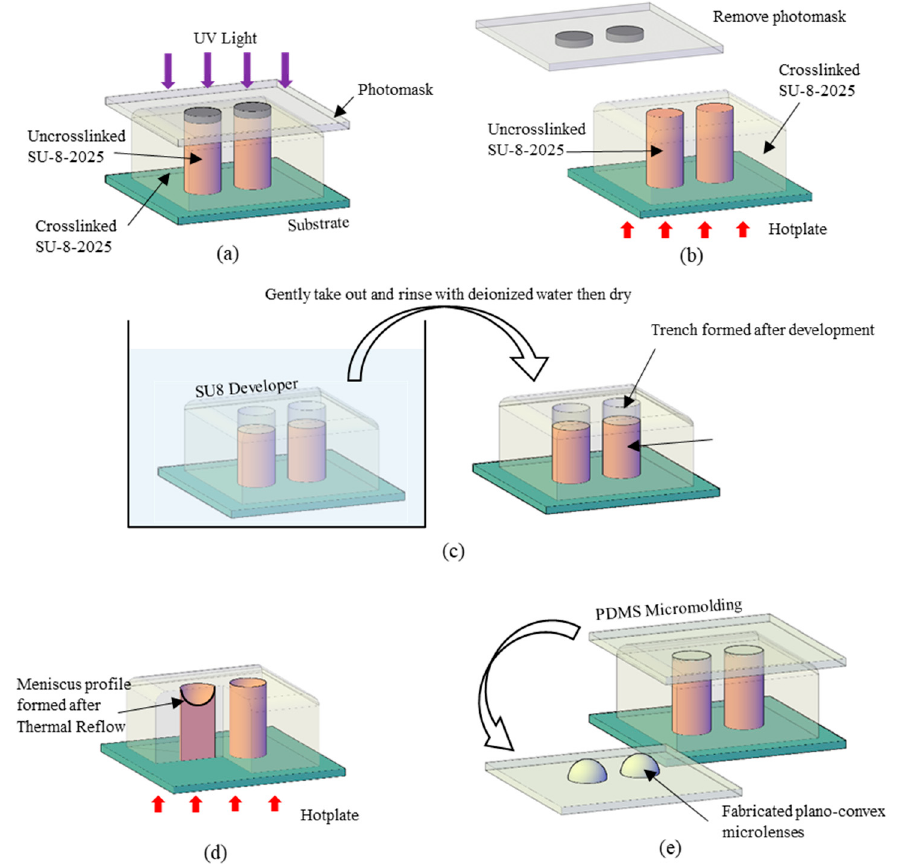
Figure 5. Major fabrication steps of the TDTR process: ( a ) UV exposure with a pre-designed photomask placed on the photoresist (SU-8); ( b ) remove mask after UV exposure then post-exposure-bake; ( c ) Timed-Development in SU-8 developer (PGMEA); ( d ) Thermal-Reflow to form meniscus profile; ( e ) PDMS micro-molding for microlens arrays.